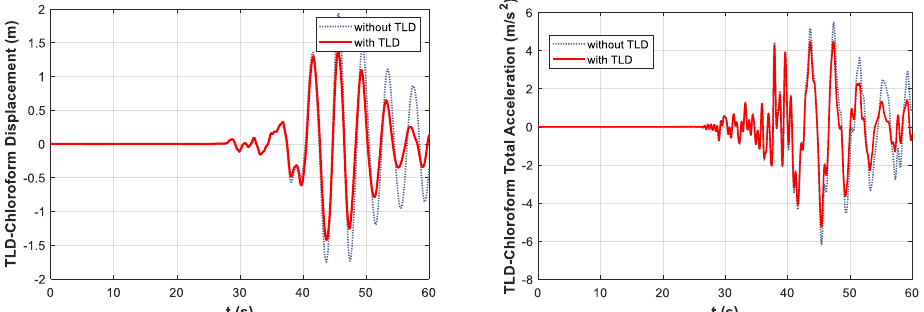
Figure 17. AHS optimization of the 40-story structure displacement – time and total acceleration – time graphs in the CHICHI/CHY101-N earthquake record for TLD – chloroform.